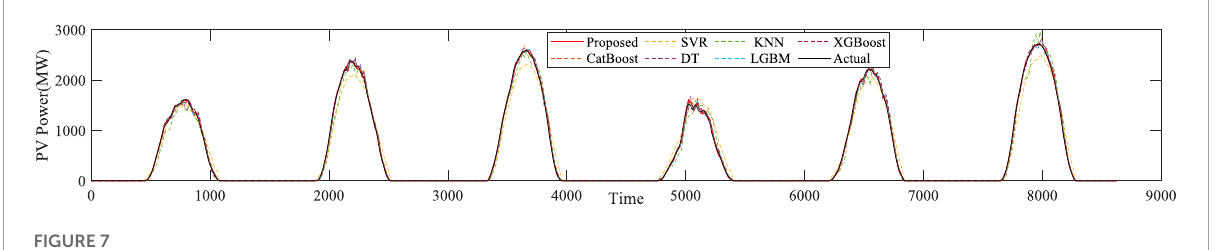
FIGURE 7 15-minutes-ahead forecasting results in spring.